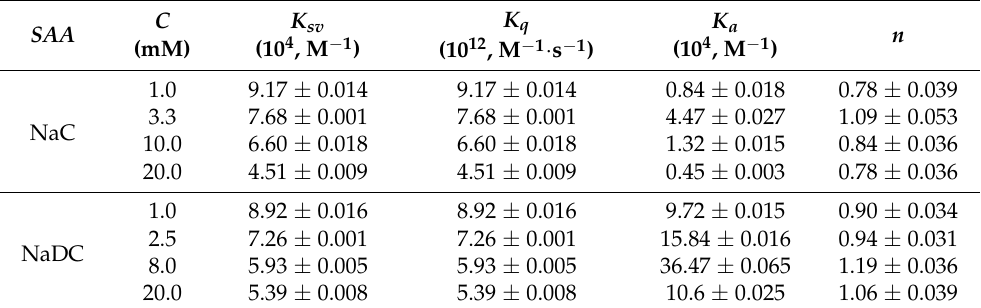
Table 3. Quenching constants and binding constants of the interaction between Hb and CAPE in the presence of NaC or NaDC in pH 7.4 buffer solution at different surfactant concentrations.